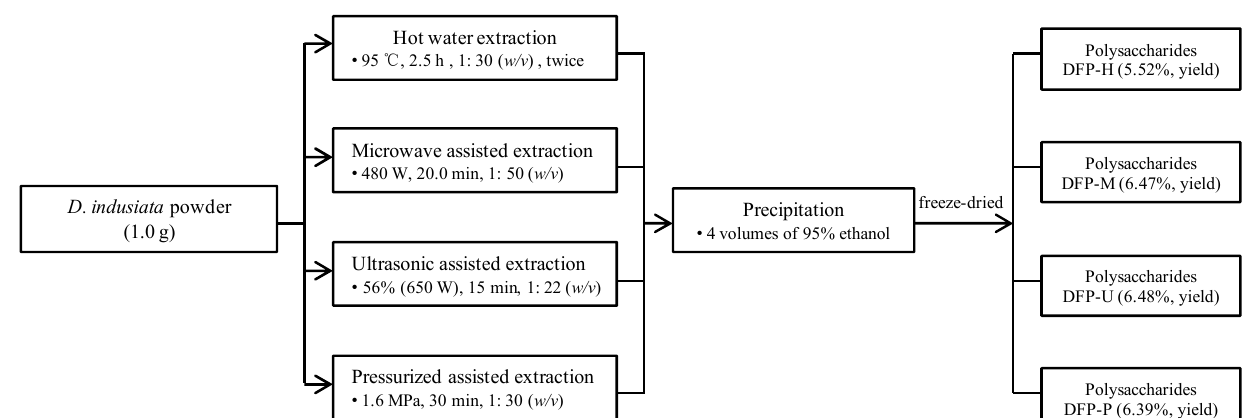
Figure 1. The flow chart for the extraction of polysaccharides from D. indusiata by different techniques. DFP-H, DFP-M, DFP-U, and DFP-P, D. indusiata polysaccharides prepared by hot water extraction, microwave assisted extraction, ultrasonic assisted extraction, and pressurized assisted extraction, respectively.